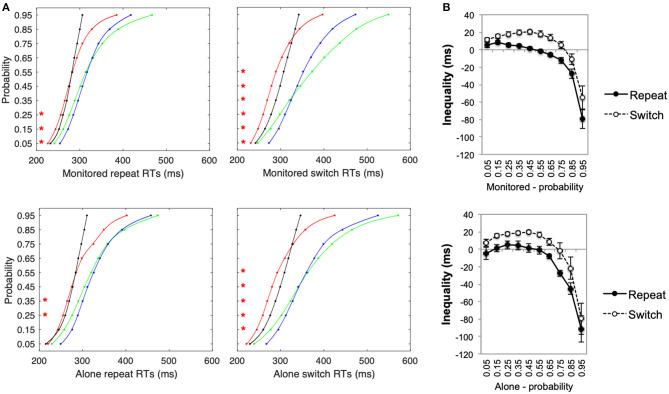
Experiment 1 (A) Cumulative probability functions (CPFs) for auditory (green), visual (blue), multisensory stimuli (red), and for the summed probability of the unisensory stimuli (AT+VT CDF—i.e., test of inequality, black) for repeat and switch trials under alone and monitored experimental conditions. (B) Inequality calculated as the difference between the AVT CDF (red line) and the AT+VT CDFs (black line) for repeat and switch trials under alone and monitored experimental conditions. Red *p < 0.05.